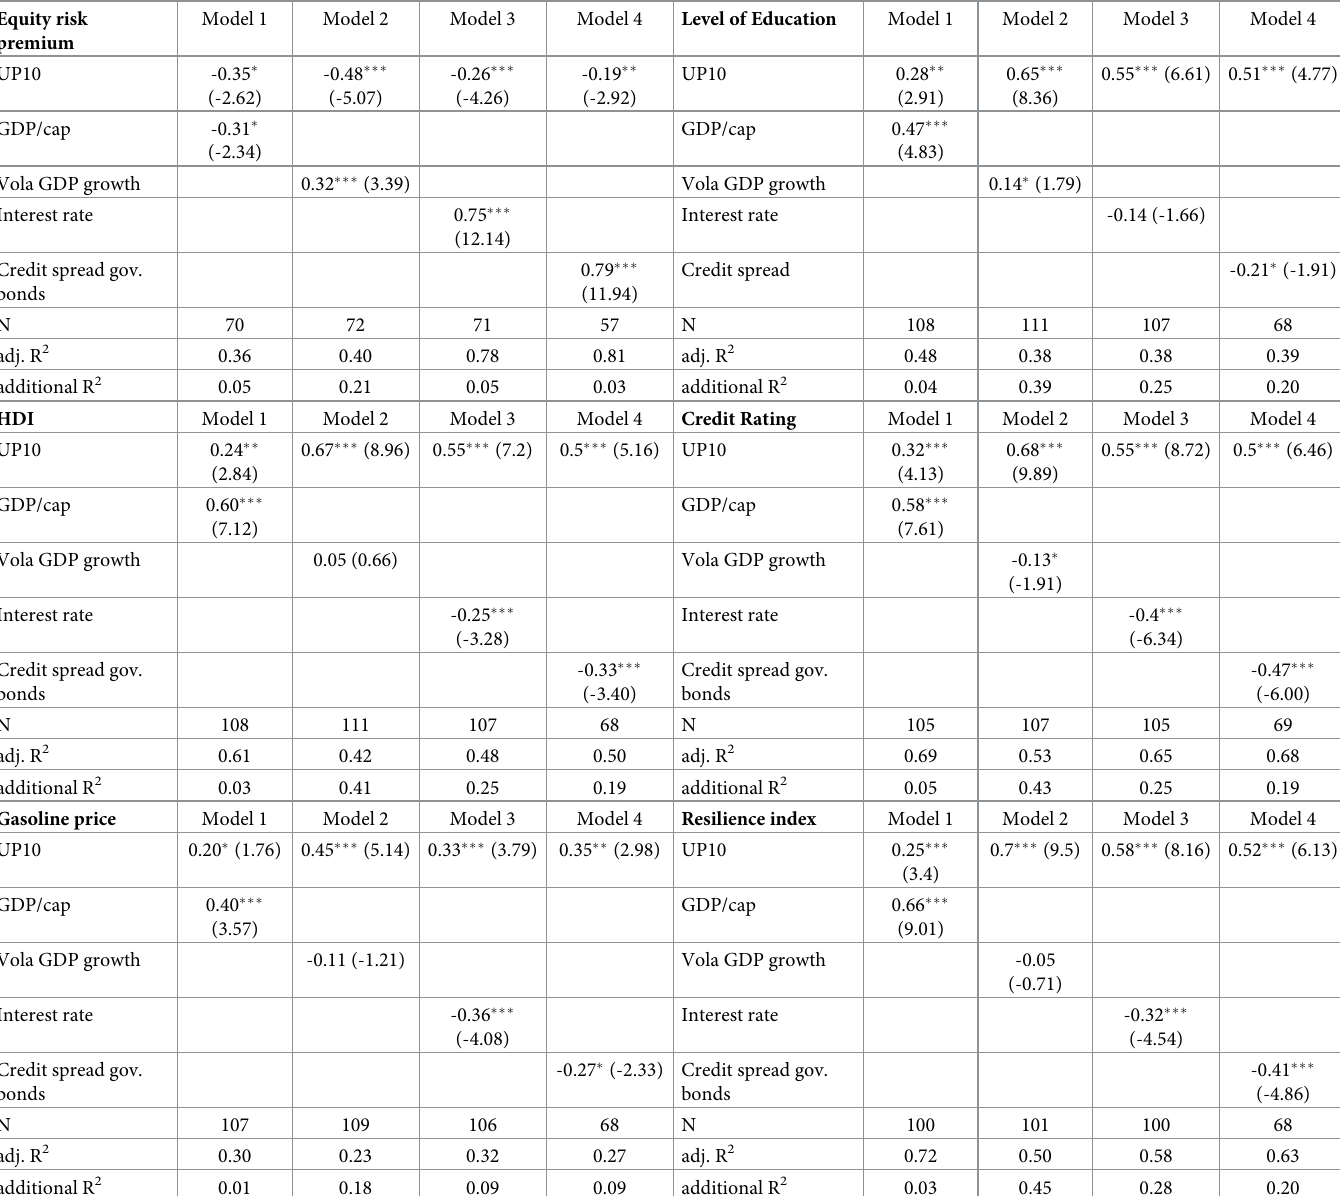
Table 5. Regression analysis for external